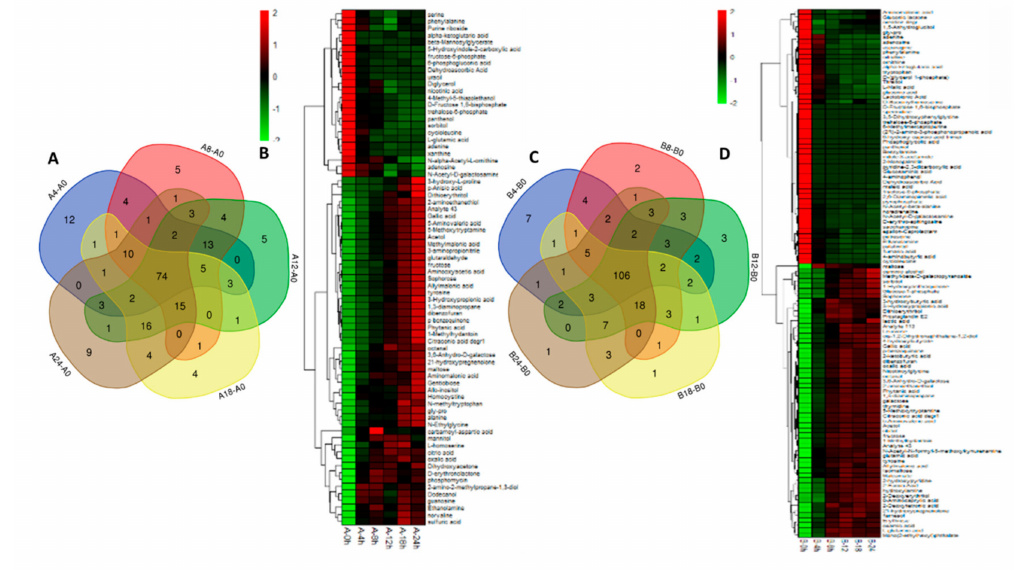
Figure 5. Venn diagram and heat map of di ff erent metabolites. ( A , C ) Venn diagram analysis of di ff erent metabolites from strains 18 and 18N44 under di ff erent heat stress durations. ( B , D ) Using Venn diagram analysis results, the heat map shows the significantly di ff erent metabolite changes of strains 18 and 18N44 under di ff erent heat stress